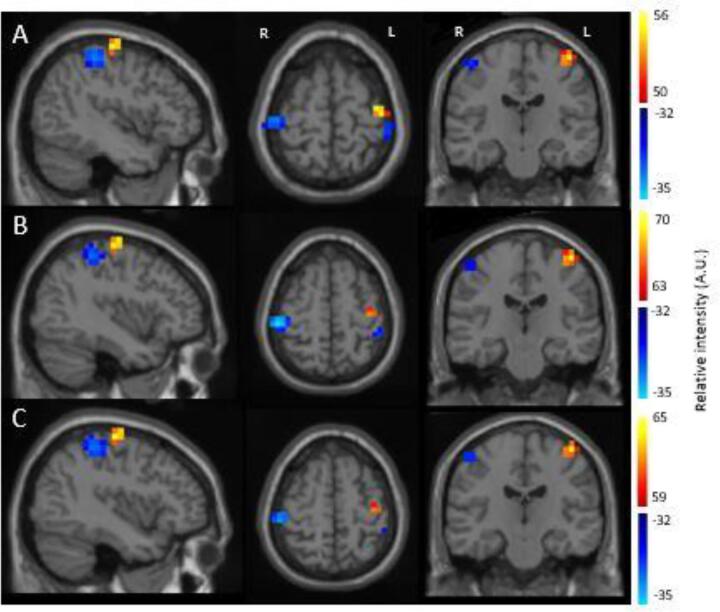
Visuo-motor task source localisation. Localisations shown for beta desynchronization (blue) and beta rebound (yellow/red) (radiological view; left on right) for A) CT group, B) RO patients and C) ES patients. Images were thresholded to show > 90% of maximum intensity for PMBR and minimum intensity for MRBD. (For interpretation of the references to colour in this figure legend, the reader is referred to the web version of this article.)